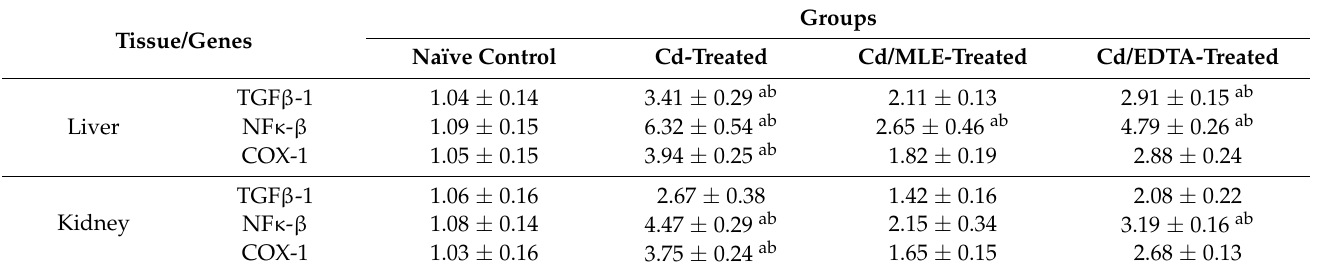
Table 5. Fold changes of the mRNA expression of TGF β -1, NF κ - β , and COX-1 genes in liver and kidney tissues of the different